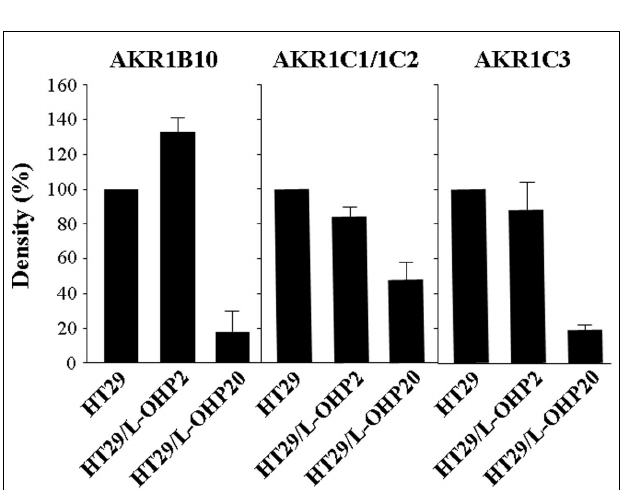
FIGURE 2 | Expression levels ofAKRs in parental and L-OHP-resistant HT29 cells. The cells were grown in Dulbecco’s modified Eagle’s medium supplemented with 10% fetal bovine serum and antibiotics.The two L-OHP-resistant cells HT29/L-OHP2 and HT29/L-OHP20 were prepared by exposing of the parental cells to incremental stepwise concentrations (0.05–2 and 20 μ M, respectively) of L-OHP.The amounts of AKR1B10, AKR1C1/1C2, and AKR1C3 in the cell extracts were analyzed byWestern blotting using the antibodies against the enzymes (Matsunaga et al., 2011).The density of the immunoreactive band is normalized to that in the parental cells (taken as 100%), and expressed as the mean ± SD of three independent experiments. AKR1C1/1C2: total amount of AKR1C1 and AKR1C2 detected by the antibody cross-react with the two